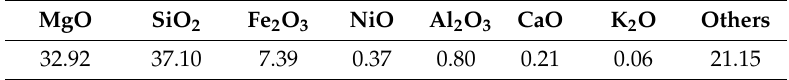
Table 3. Chemical compositions of the serpentine single mineral (mass